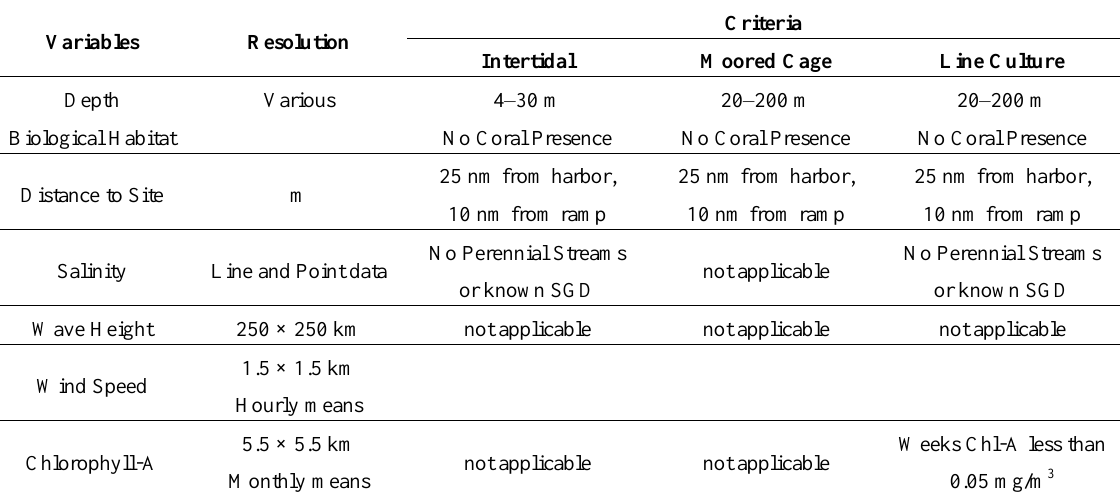
Table 4. Parameters used in the final models and associated scale (temporal and spatial).